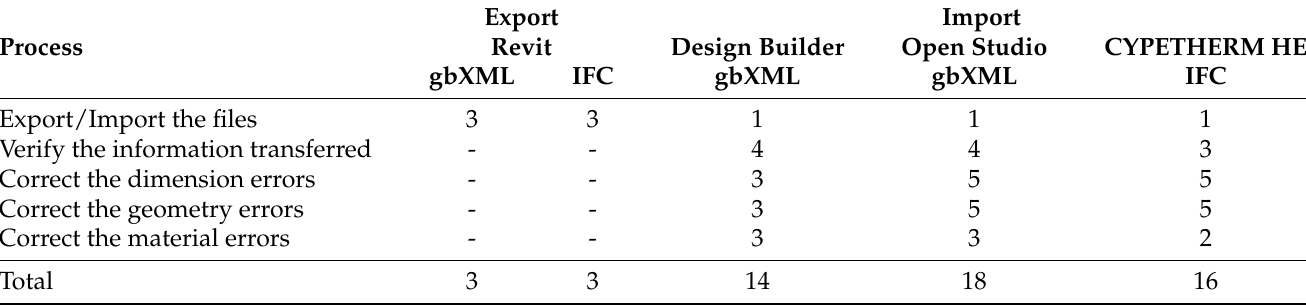
Table 4. Comparative table with assessment of the processes. Scale range: 1 to 5, where 1 means the most feasible.